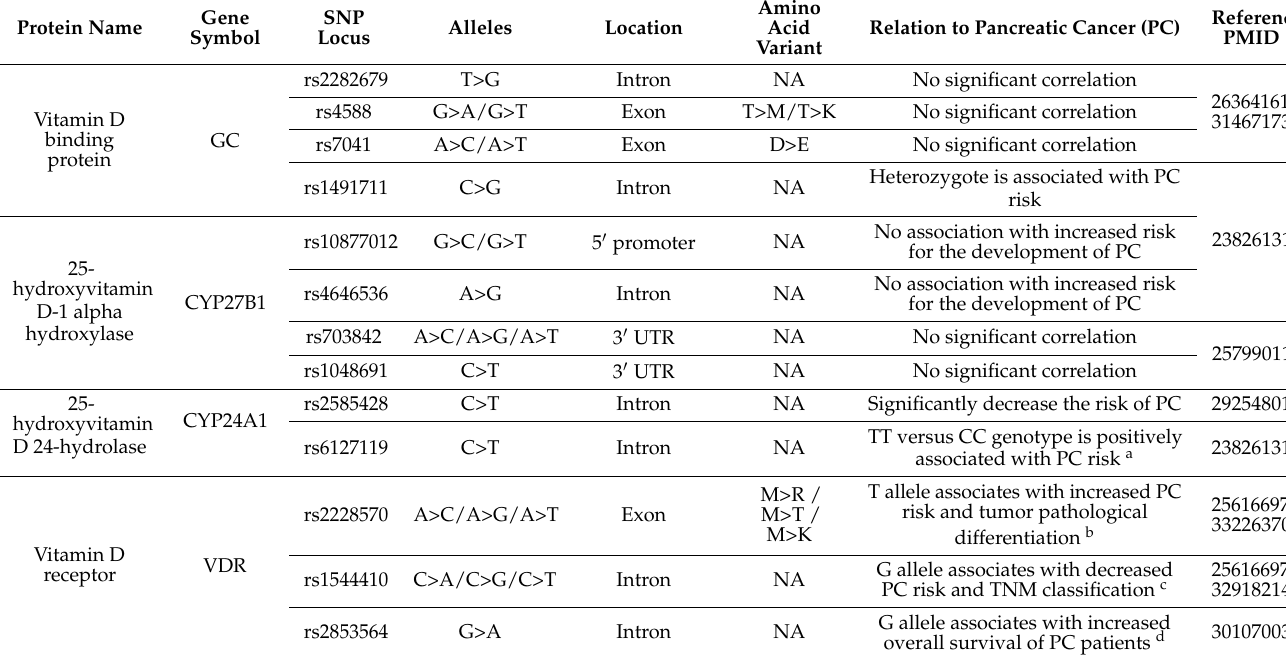
Table 1. Relationship of SNPs in vitamin D metabolic and VDR signaling pathways with pancreatic